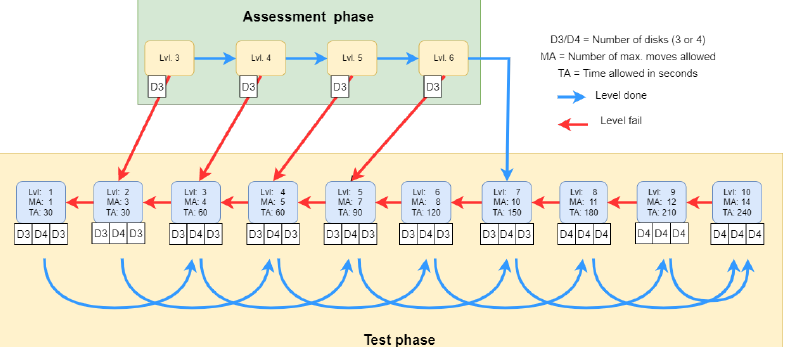
Figure 4. The algorithm of Tower of London Adaptive Test. Blue arrows represent the step if a test level is done, and red arrows the failing of a test. D3 and D4 represent the number of discs in the test case (three discs and four discs respectively). MA denotes the allowed maximum moves, and TA stands for the allowed maximum